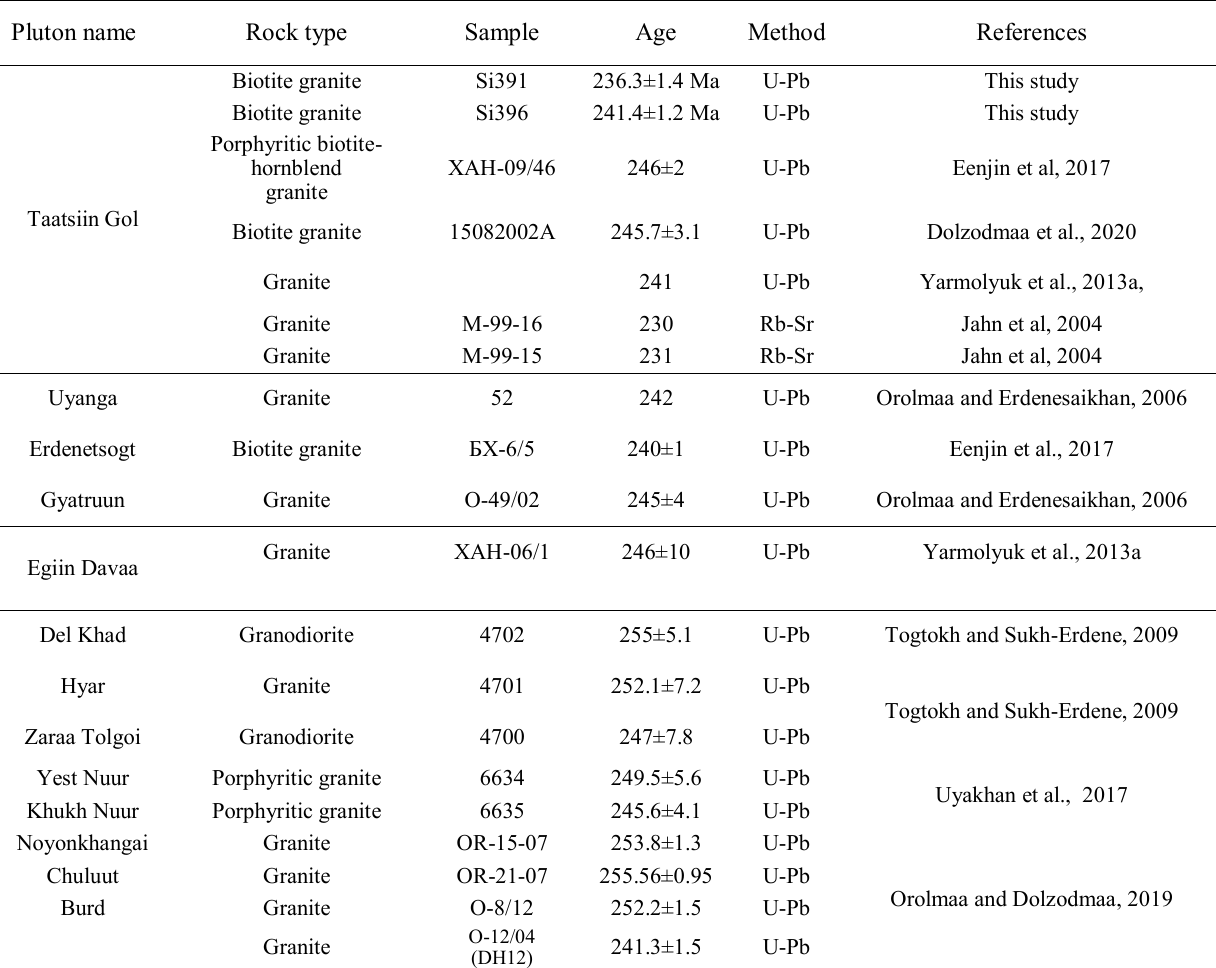
Table 4. Summary of age data of the Khangai